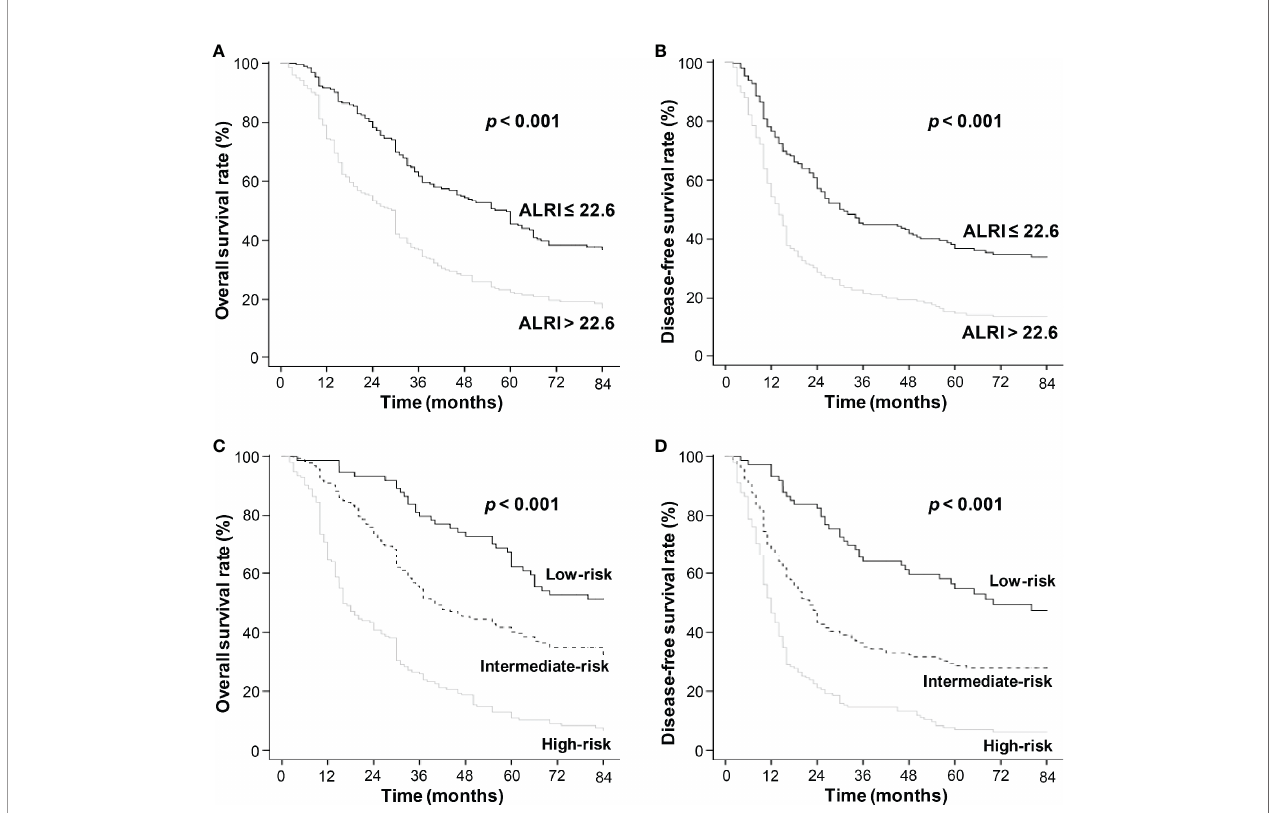
FIGURE 5 | The OS and DFS curves in the training cohort. Kaplan-Meier survival analyses revealed that HCC patients with ALRI > 22.6 had shorter OS and DFS (A, B) . The black line refers to ALRI ≤ 22.6 and the gray line refers to ALRI > 22.6. Kaplan-Meier survival analyses of HCC patients in different risk groups (C, D) . The black line refers to low-risk group, the dotted line: intermediate-risk group and the gray line: high-risk